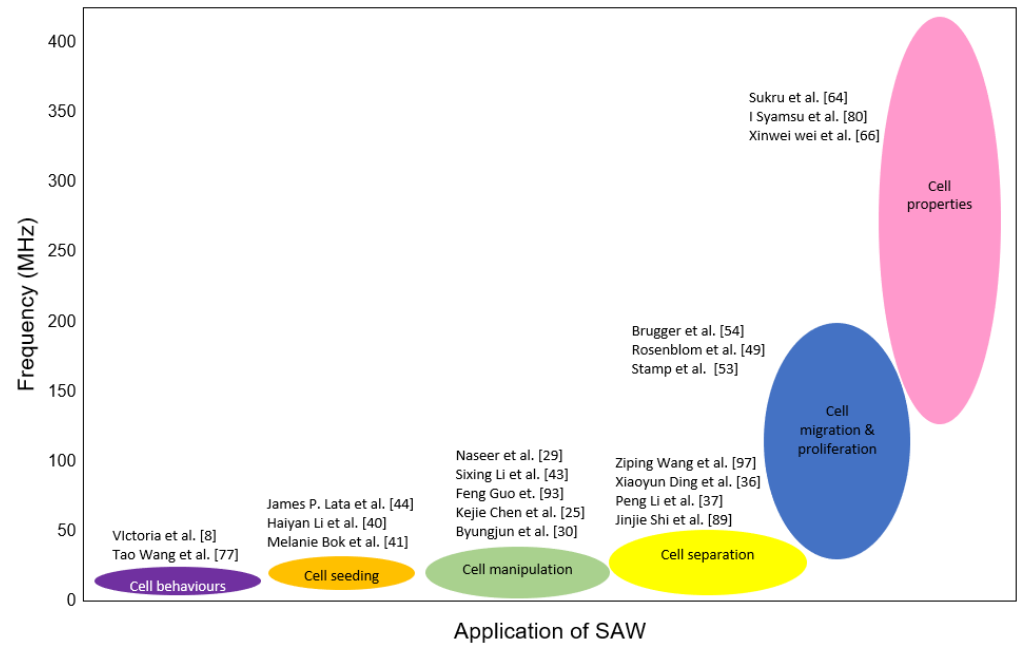
Figure 13. The range of acoustic wave excitation has drawn the interest of many researchers in the last decade.